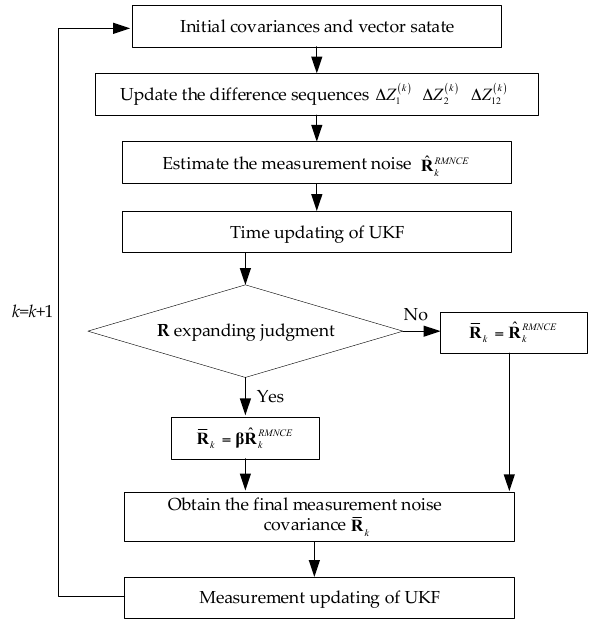
Figure 2. The flow chart of the proposed adaptive RMNCE-UKF.